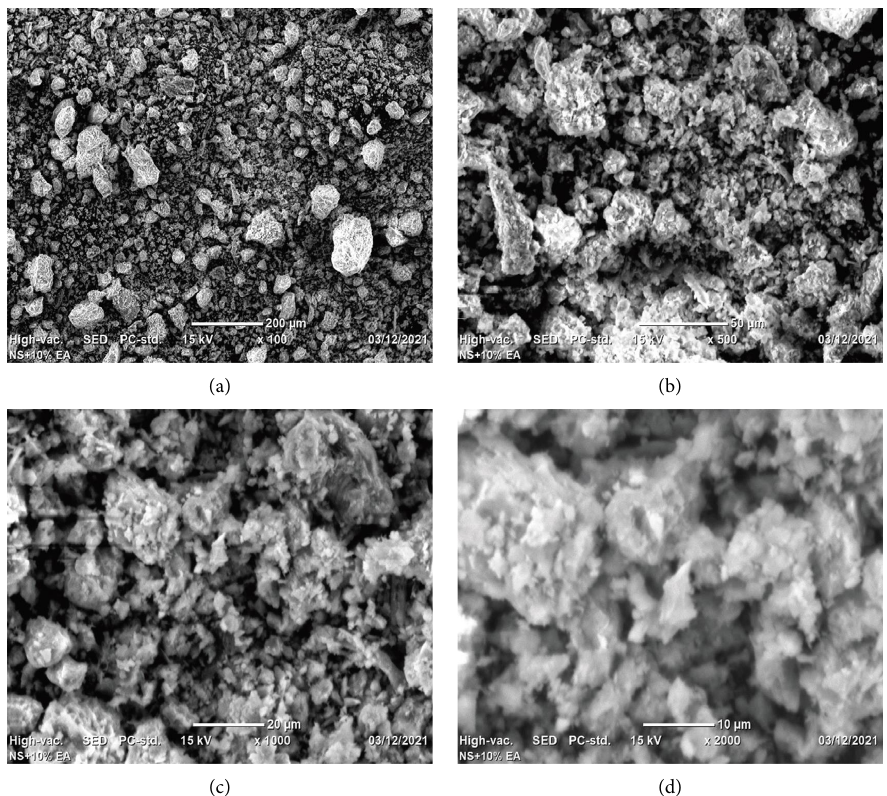
Figure 6: SEM image of 90% natural soil with 10% Enset ash at diferent magnifcation factors. (a) × 100. (b) × 500. (c) × 1000. (d) ×